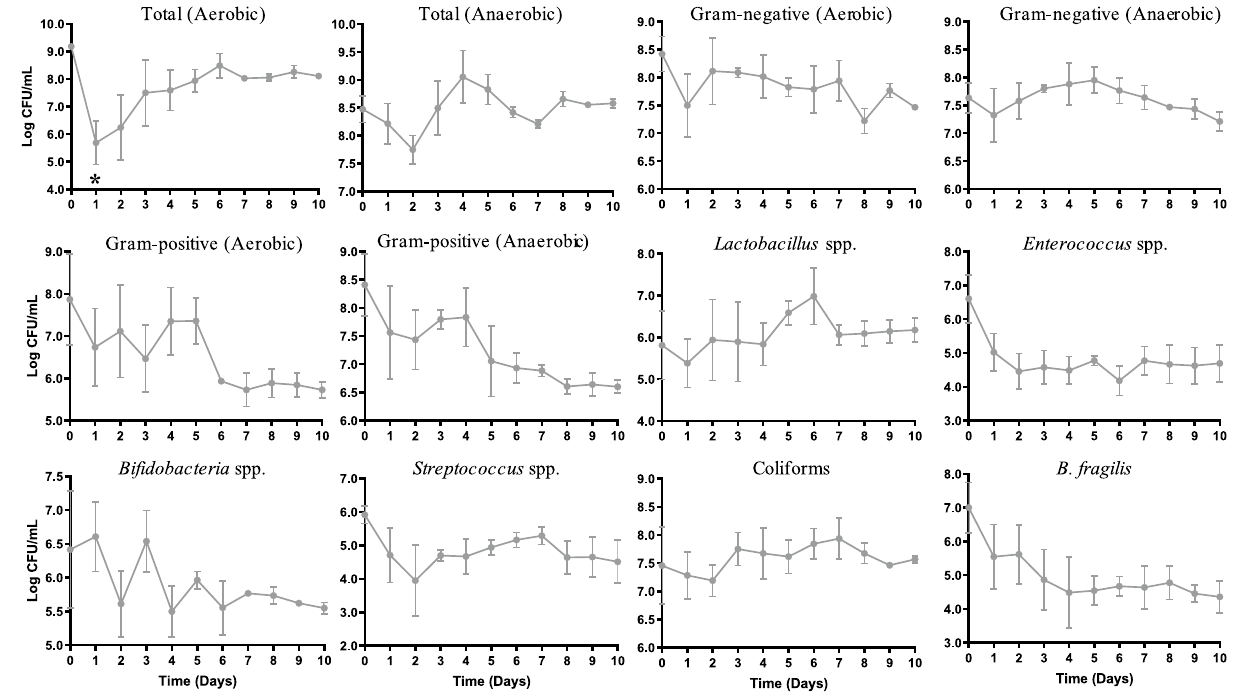
Figure 2. Viable cell counts following fecal inoculation. Viable cell counts of 12 groups of commensal gut microbiota were assessed for 10 days following fecal inoculation on selective agar plates. Plating of serial dilutions allowed the number of colony forming units (CFU) to be determined each day. Each time-point represents n = 3 independent trials +/− SEM. Variability over time was conducted with a one-way ANOVA using Kruskal Wallis analysis where *p < 0.05.